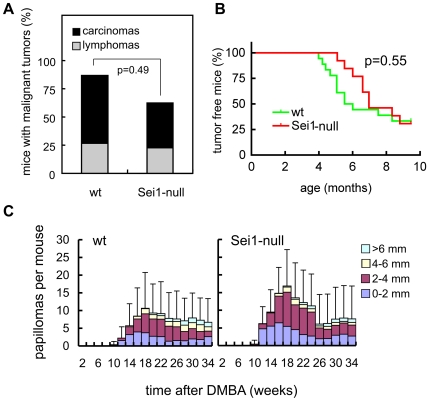
Cancer susceptibility in Sei1-null mice.
(A) Spontaneous cancer incidence and spectrum in old moribund mice (n = 15 for wt mice, and n = 26 for Sei1-null mice). Presence and type of cancer was determined upon detailed histopathological analyses by one of the authors (J.M.F.). Fisher's exact test was used to determine statistical differences in total cancer incidence. (B) Latency of fibrosarcoma development after intramuscular injection with 3MC represented by Kaplan-Meier curves (n = 16 for wt mice, and n = 13 for Sei1-null mice). Statistical analysis was performed using the Logrank test. (C) Papilloma latency, incidence and size after DMBA/TPA tumorigenesis in mice of the indicated genotypes (n = 14 per genotype). Bars correspond to the s.d. of the average number of total papillomas per mouse. Student's t-test was used to compare the two genotypes but no significant differences were found.